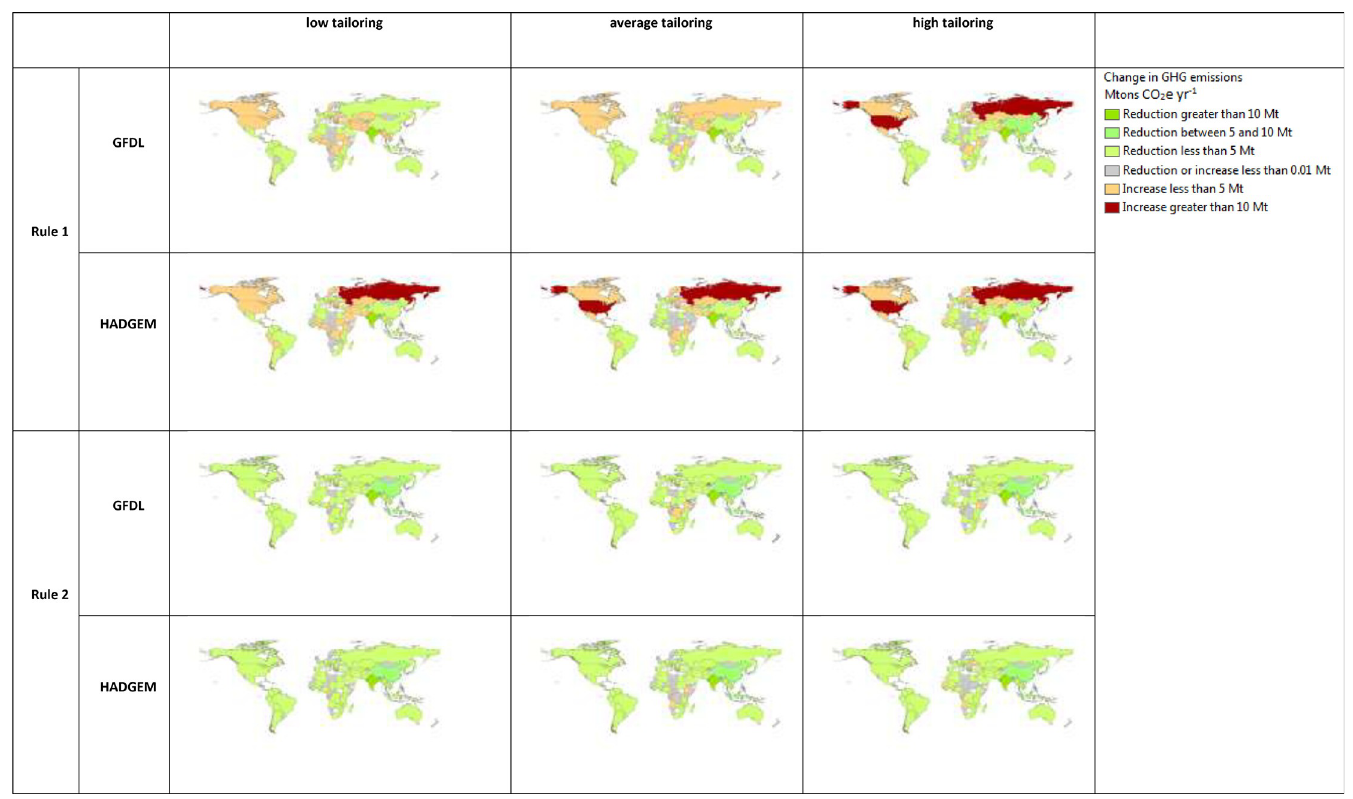
Fig 3. Average change in GHG emissions by country for alternative scenarios and tailoring of CSA practices, comparing years 2010 and 2050. Negative values indicate an abatement compared to BAU and positive values an increase. Source: Authors.